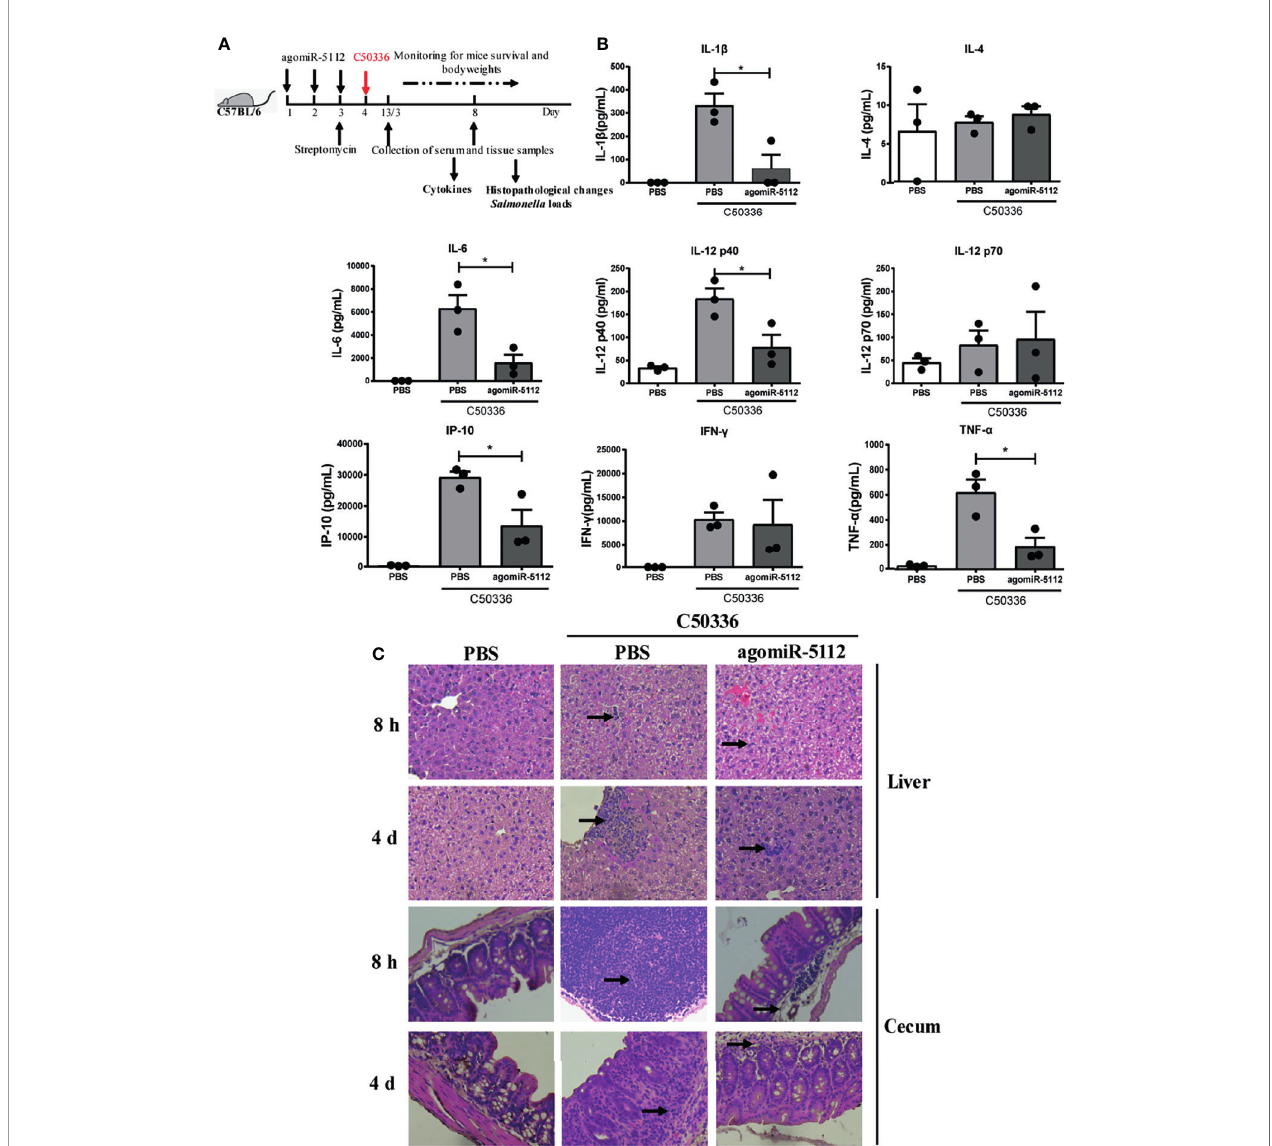
FIGURE 5 | Exogenous miR-5112 agomiR inhibits the in fl ammatory response induced by S . enteritidis infection in mice. (A) Schematic diagram of the experimental design. AgomiR-5112 was delivered into C57/BL6 mice (n=12) by intraperitoneal injection on three consecutive days (day 1 to 3). Additionally, 7.5 mg of streptomycin was administered to the mice by oral gavage on day 3. After 24 h, the mice were infected with 5 ×10 4 CFU of C50336 (100 - m l of bacterial suspension in PBS) or treated with 100 m l of sterile PBS (control) by oral gavage. At 8 hours and 4 days after Salmonella infection, three mice per group were sacri fi ced, and serum, liver, and cecum were collected. (B) The cytokines in serum from mice (n=3/group) at 4 days after Salmonella infection were measured using the Millipore Milliplex MAP Mouse Cytokine/Chemokine Panel I according to the manufacturer ’ s instruction. Data are expressed as the mean ± SEM. * P < 0.05. (C) Histopathological changes in liver and cecum of mice at 8 hours and 4 days after Salmonella infection examined by H&E staining and observed at ×100 magni fi cation using an optical microscope. Arrows indicate in fl ammatory cell in fi